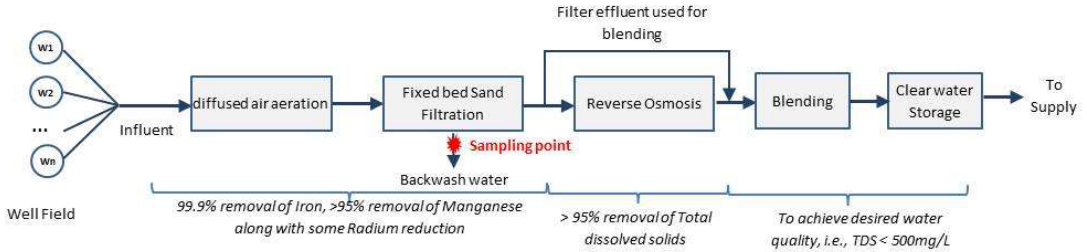
Figure 2. Schematic diagram of water treatment processes in Buraydah, Qassim, Saudi Arabia.